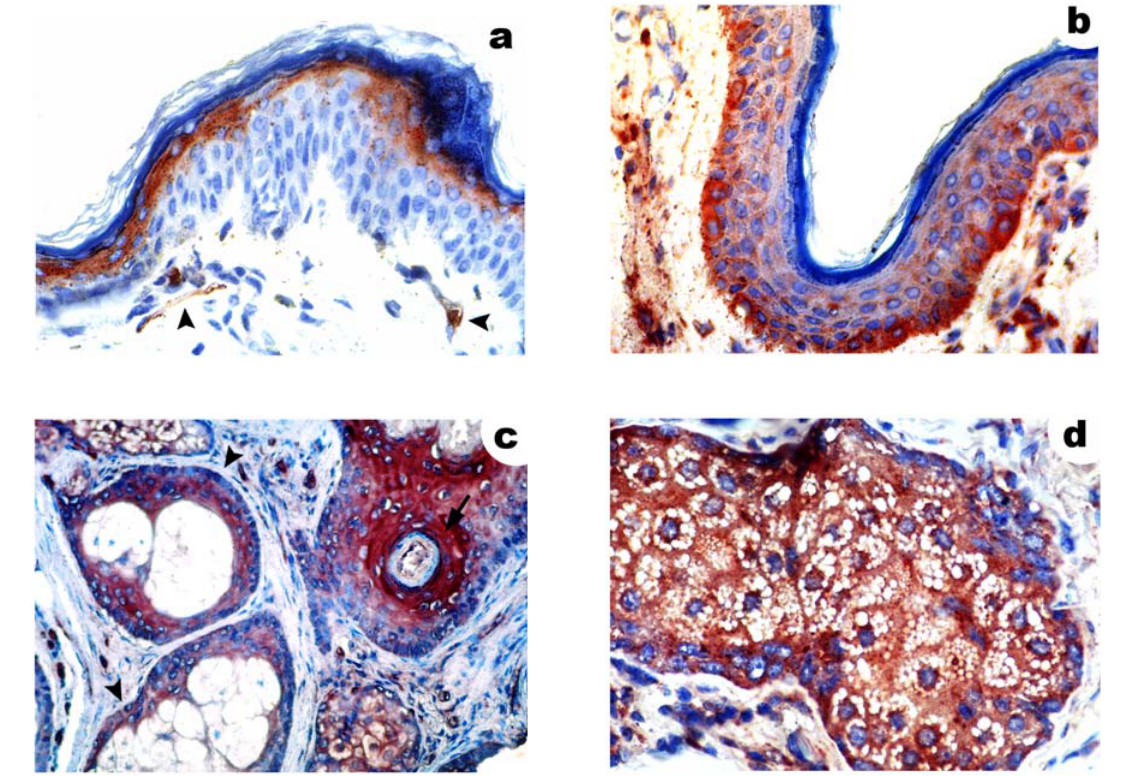
Fig. 1 Expression of HBGAs and LAMPs in normal human skin (Biotin-streptavidin- peroxidase